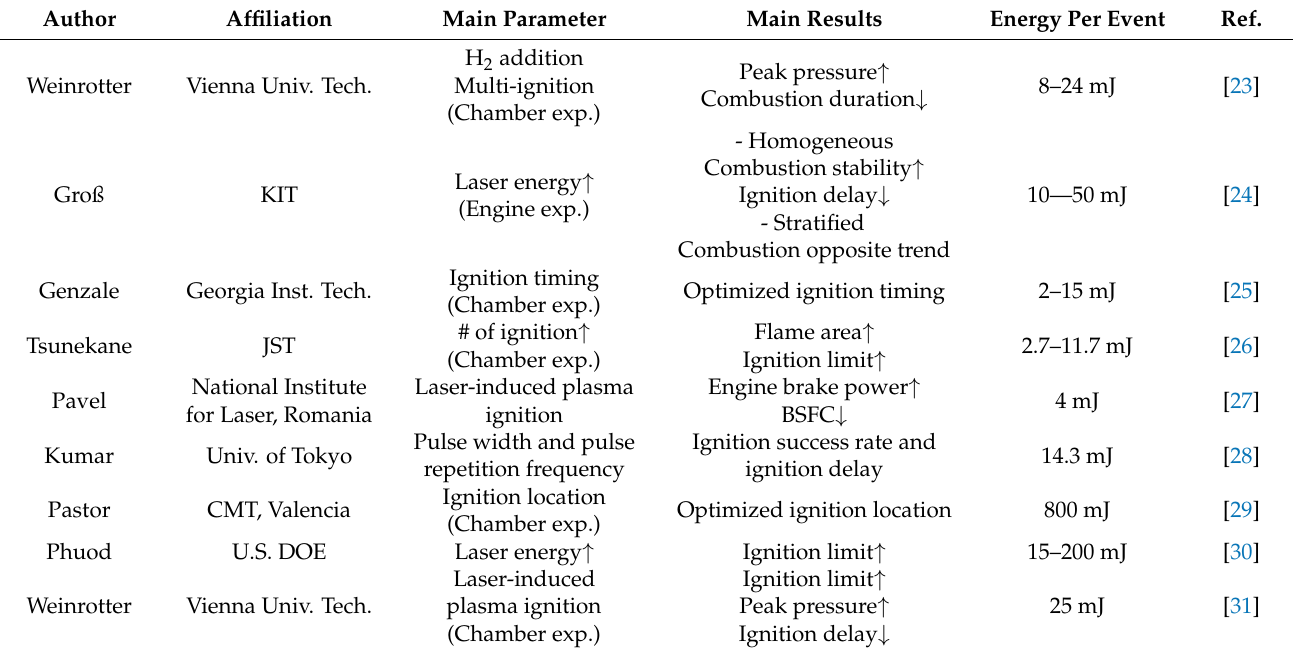
Table 2. Summary of the effect of laser-induced plasma ignition on